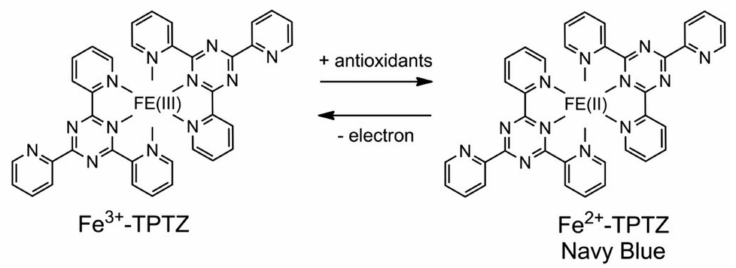
Figure 5. Formation of Fe 3+ and Fe 2+ during the electron reception and donation in FRAP